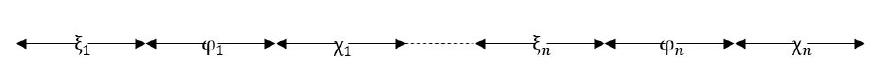
Figure 1. The renewal process of the two-unit series system with three